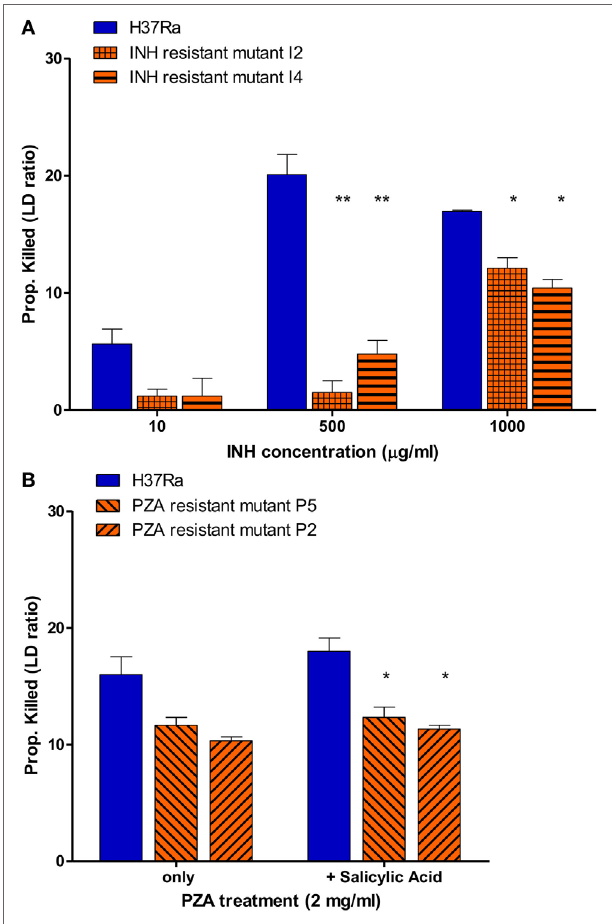
FigUre 6 | Drug susceptibility testing of Mycobacterium tuberculosis against first-line tuberculosis drugs using the SYBR Green I/propidium iodide (PI) assay. (a) M. tuberculosis H37Ra and INH-resistant mutants I2, I4 (10-day old) were treated with 10, 500, and 1,000 µg/ml INH overnight (16 h). INH-resistant mutants I2 and I4 were determined to be resistant using 500 and 1,000 µg/ml INH. (B) M. tuberculosis parental strain H37Ra and pyrazinamide (PZA)-resistant mutants (P5 and P2) (20-day old) were treated with PZA (2 mg/ml) overnight (16 h). Treatment with salicylic acid (40 µg/ml) strongly increased the efficacy SYBR Green I/PI assay in detecting PZA resistance in mutants P5 and P2 compared to parental strain H37Ra (Student’s t -test, * p < 0.05, ** p < 0.005). Data represent the means +